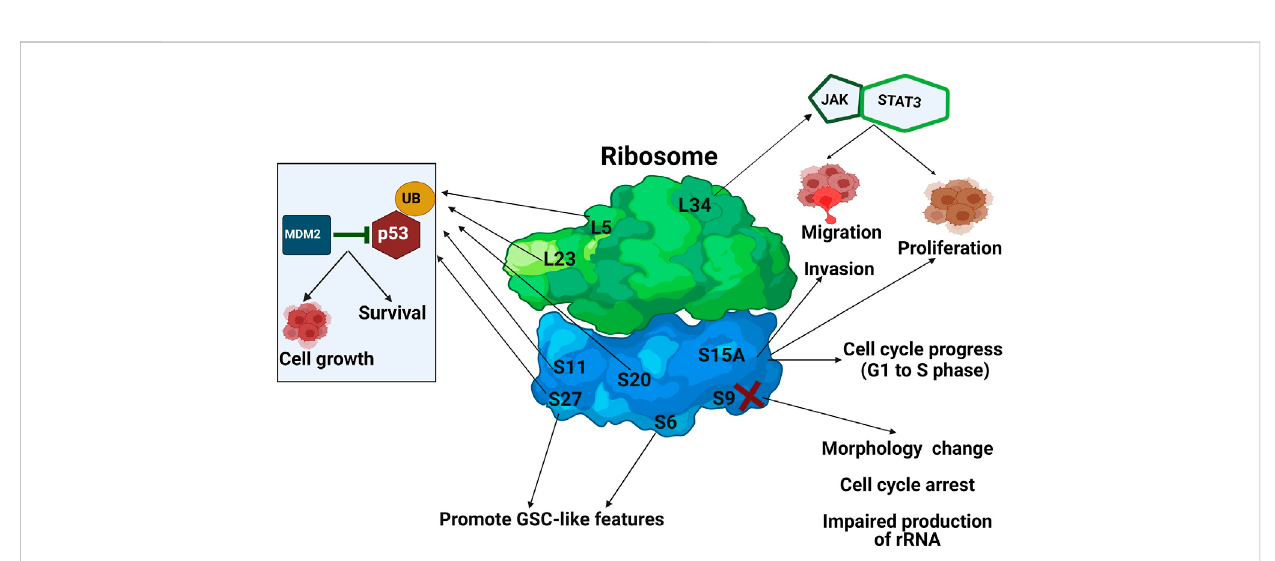
FIGURE 5 The involvement of RPs in GB. The 60S and 40S ribosomal subunits are depicted in green and blue , respectively. RPs are shown as L or S and their respective number. Arrows indicate what GB process RPs are involved in.